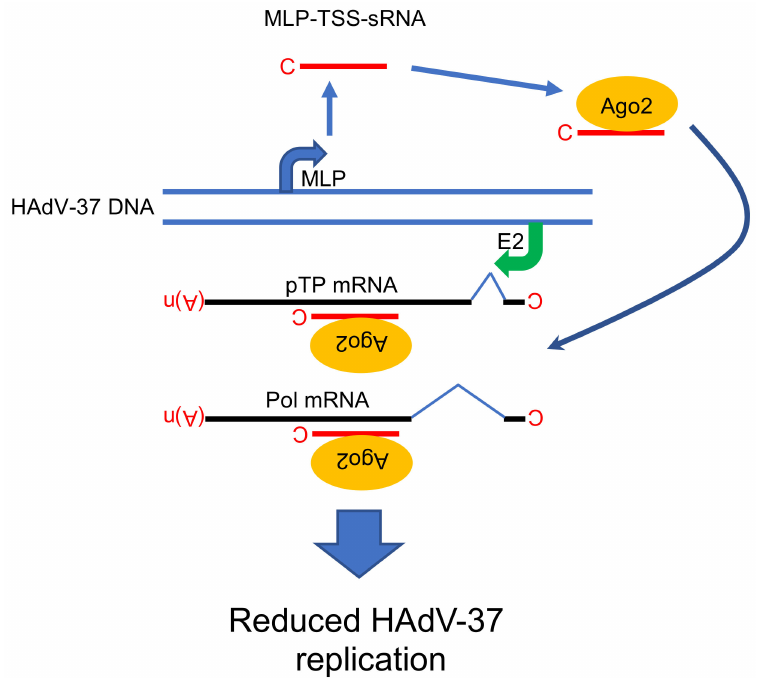
Figure 4. Proposed functional role of MLP-TSS-sRNA in HAdV-37 cells. The MLP-TSS-sRNA is in the complex with the Ago2 protein and anneals to its complementary sequence on two viral mRNAs (pTP and Pol). Abbreviations: C; (m7G)-cap structure, MLP; Major Late Promoter, E2; E2 promoter, pTP; preterminal protein, Pol; virus DNA polymerase, (A)n; poly(A) tail, Ago2; Argonaute 2 protein, MLP-TSS-sRNA; Major Late Promoter-Transcription Start Site-small RNA. Model is based on the study